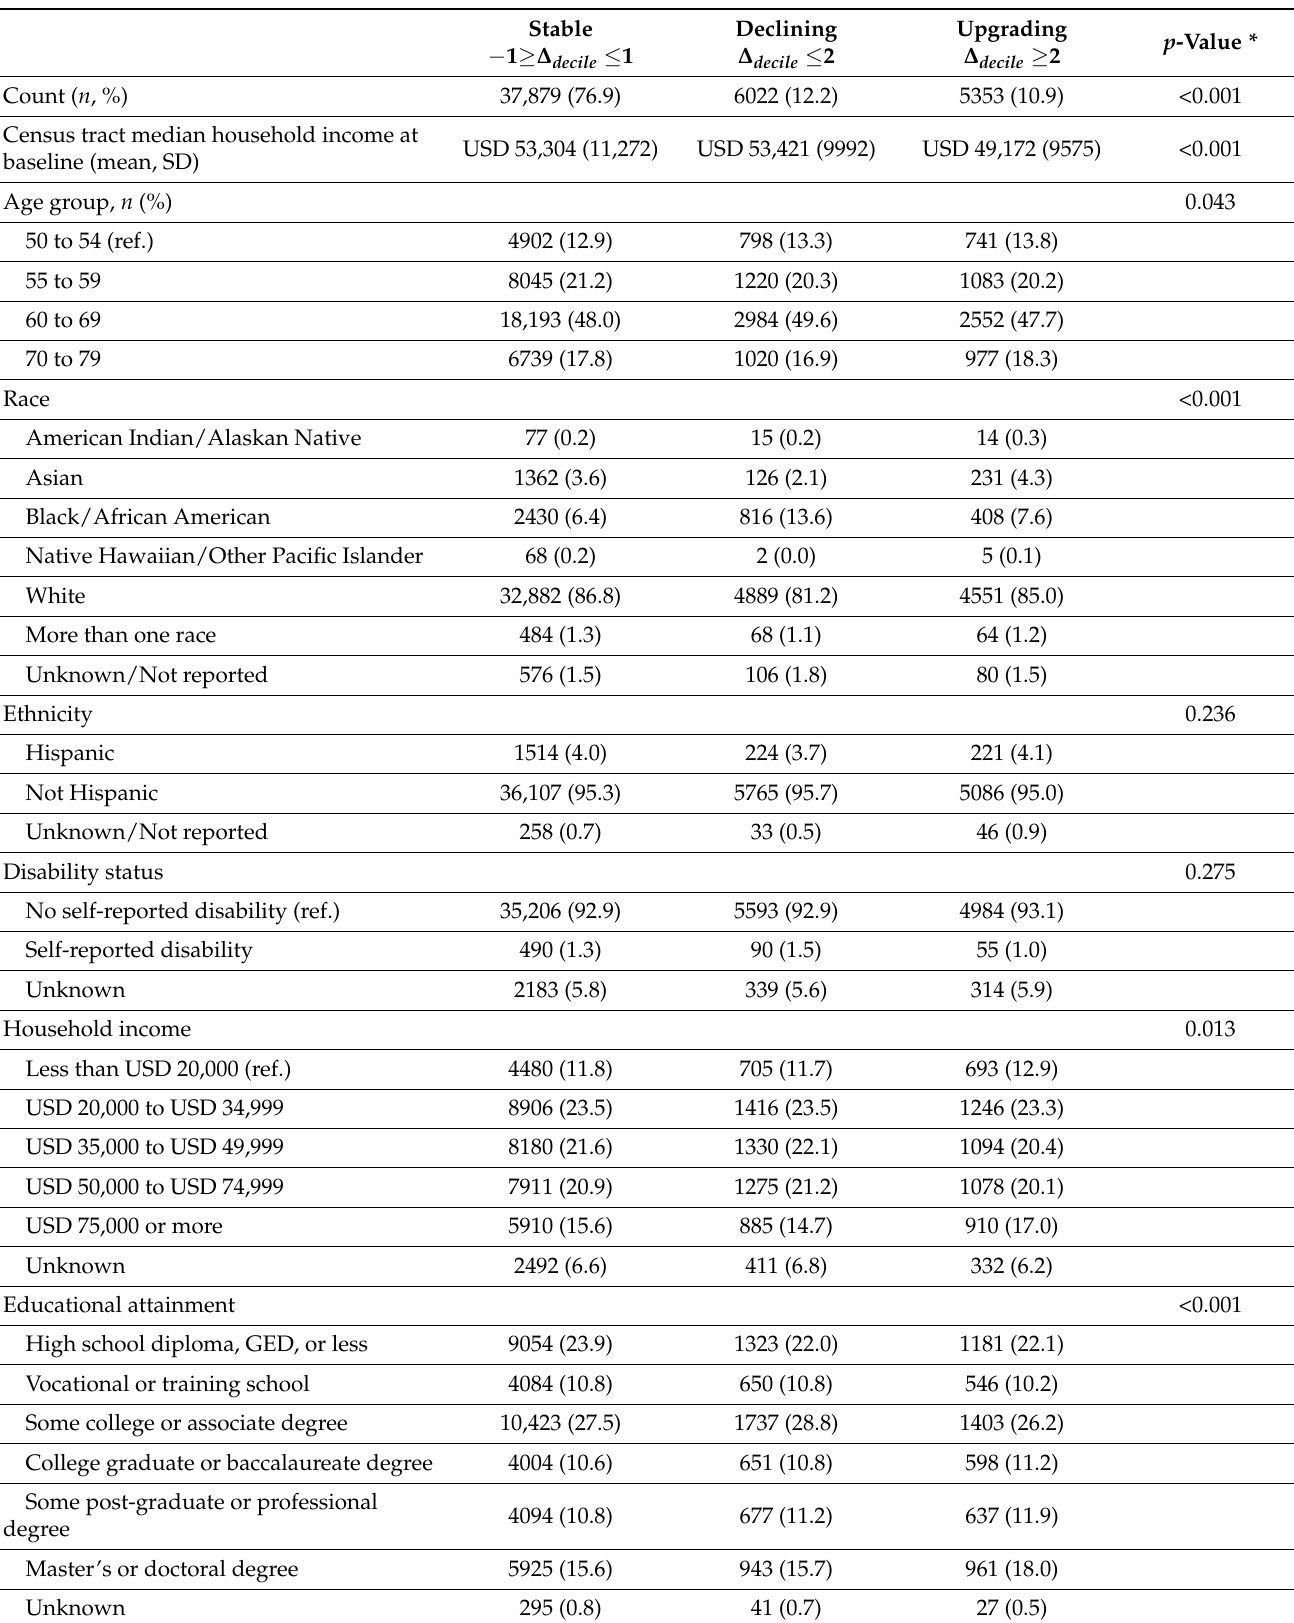
Table 1. Characteristics of study population by neighborhood change